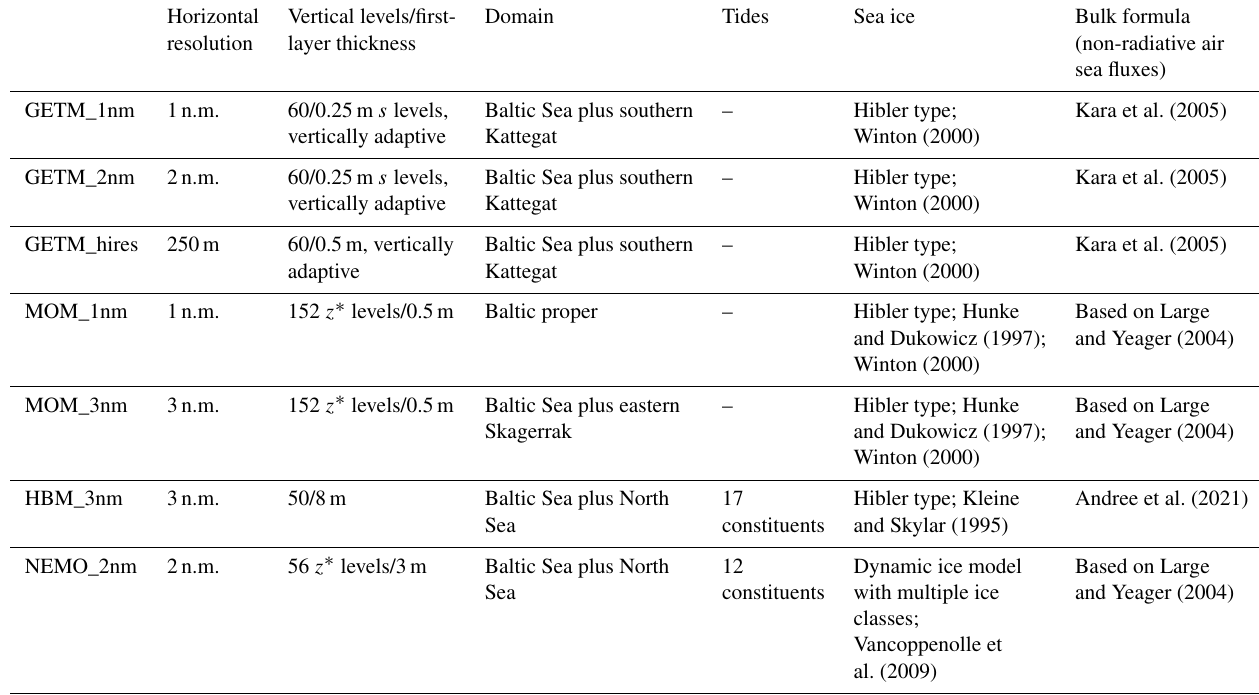
Table 1. Overview of the models used in this study (nm is nautical miles). Horizontal Vertical levels/first- Domain Tides Sea ice Bulk formula resolution layer thickness (non-radiative air sea fluxes) Baltic Sea plus southern Hibler